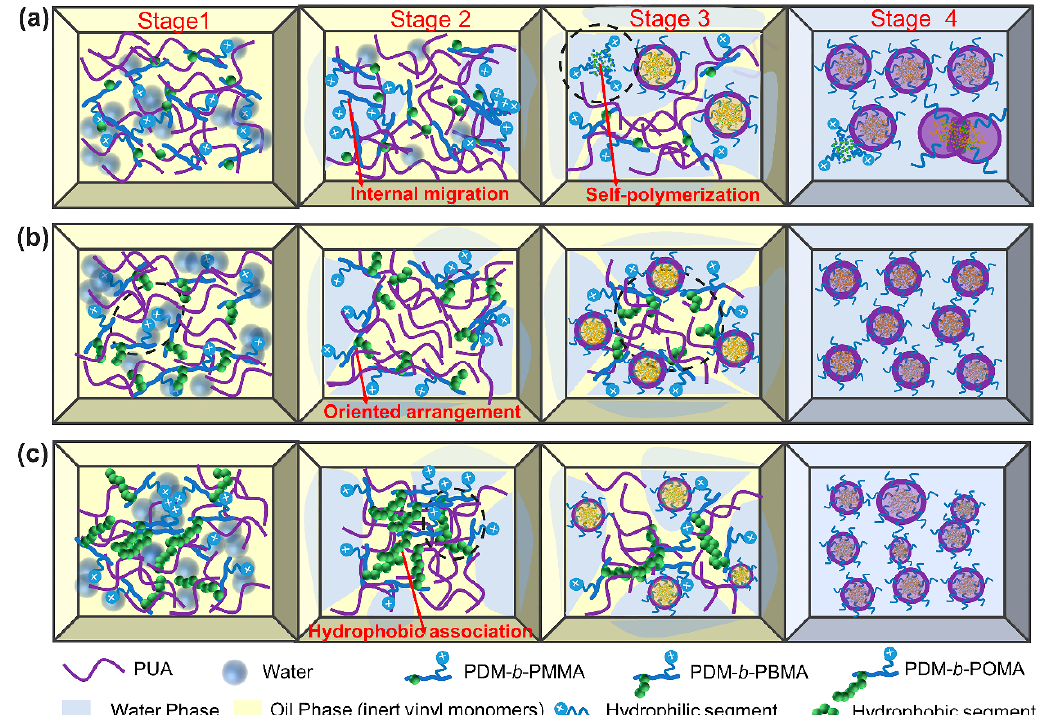
Figure 9. Schematic models of macrosurfactants PDM- b -PMMA ( a ), PDM- b -PBMA ( b ) and PDM- b -POMA ( c ) application in the phase inversion process of poly(urethane-acrylate) prepolymer at different stages.